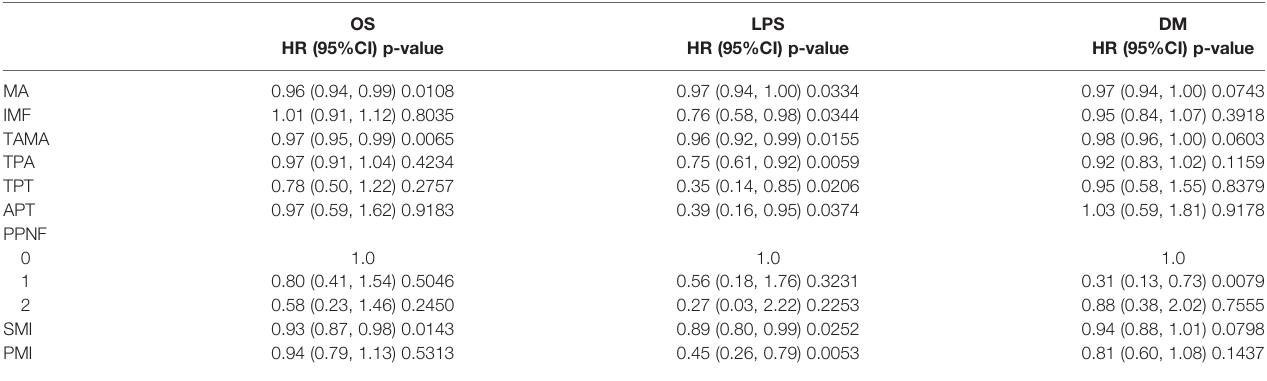
TABLE 3 | Multivariate cox proportional hazard analysis for risk factors of patients ’ prognosis.